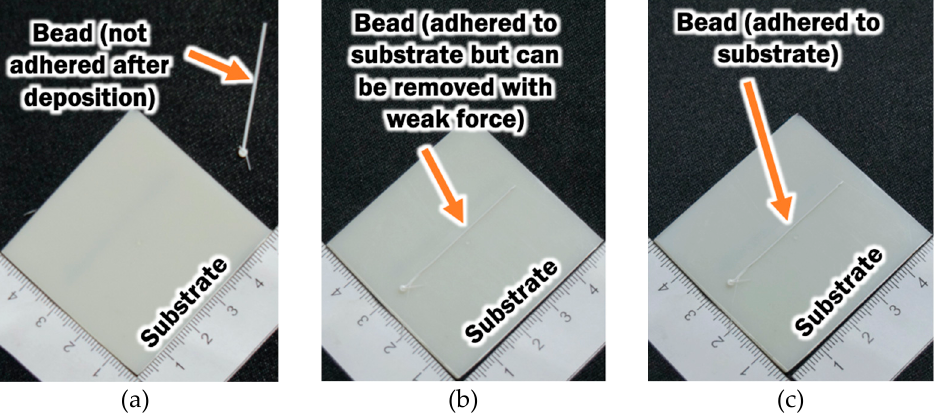
Figure 16. Bead deposited on substrate after ME process using different printing temperature and no plate heating: ( a ) T p = 230 °C; ( b ) T p = 240 °C; ( c ) T p = 250 °C.